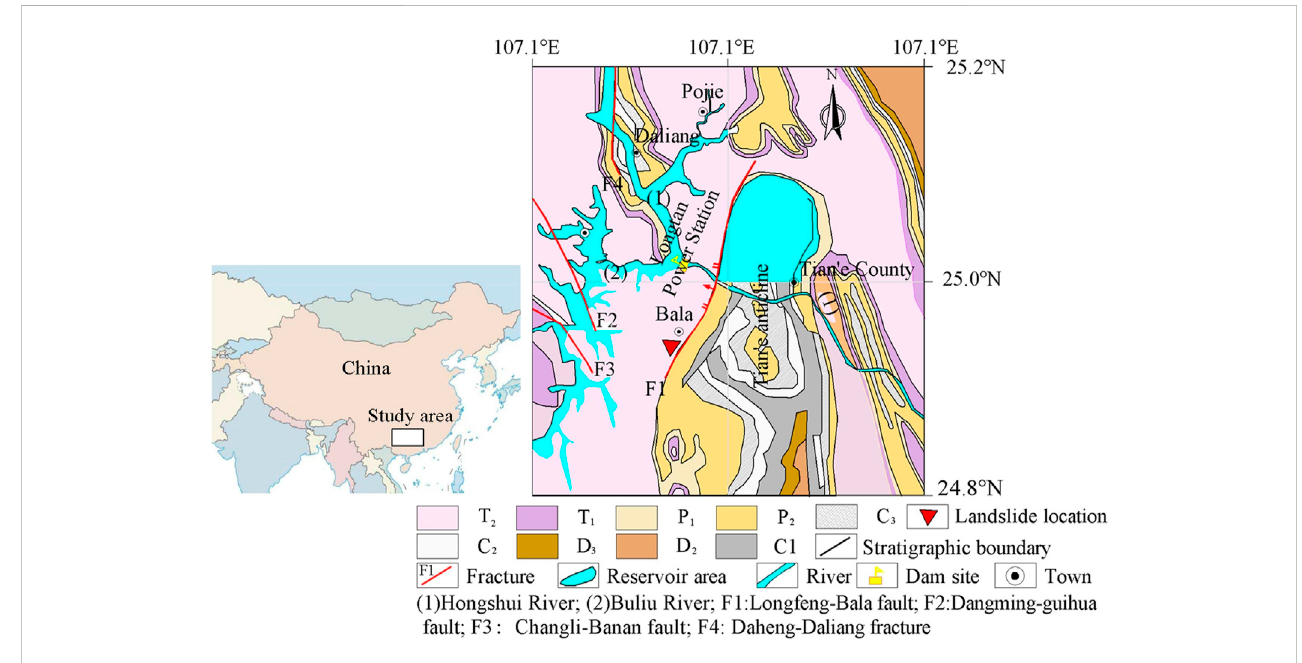
FIGURE 1 Geographical location map of landslide